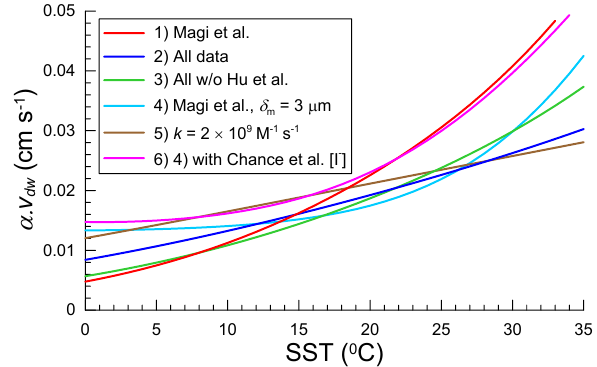
Figure 5. Variation in the oceanic component of ozone dry depo- sition velocity multiplied by ozone solubility, αv dw ( = 1 /r c ) , as a function of sea surface temperature (SST, ◦ C). Curves determined using the two-layer deposition scheme (Eq. 16) for various options for parameterising the second-order rate coefficient ( k) (see text). The waterside friction velocity ( u ∗ w ) used was 0.01ms − 1